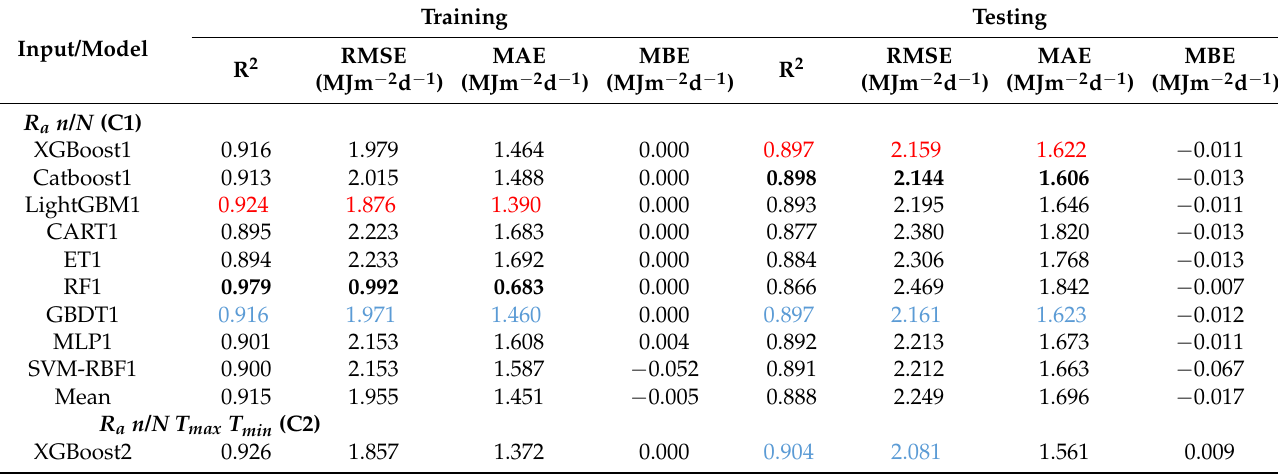
Table 6. Statistical values of the developed models (CART, ET, RF, GBDT, XGBoost, CatBoost, LightGBM, MLP and SVM) with various input combinations during training and testing stages at all stations on average (The model accuracy ranking first, second and third was highlighted in bold, red and blue,